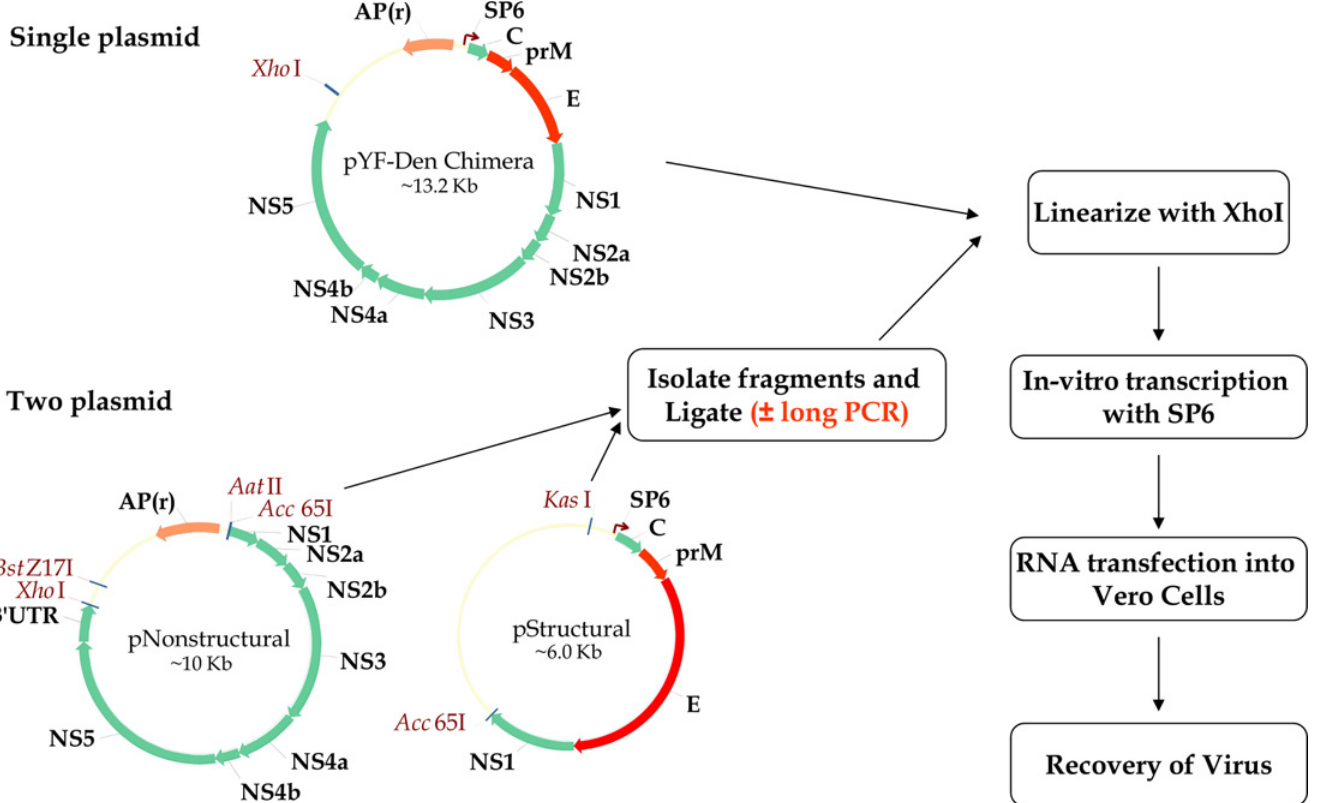
Fig 1. Outline of recombinant YF-17D-dengue chimeric virus recovery. The chimeric constructs were designed such that recombinant viruses can be recovered either by the single-plasmid (linearized single plasmid) or the two plasmid approach ( in-vitro ligation of DNA fragments). The full-length chimeric cDNA clone or in-vitro -ligated chimeric DNA was linearized with XhoI to allow for run-off transcription. A LONG-PCR step was also performed in some cases to generate templates for in vitro transcription. Chimeric full-length viral RNA transcripts thus generated were transfected into Vero cells for virus recovery.